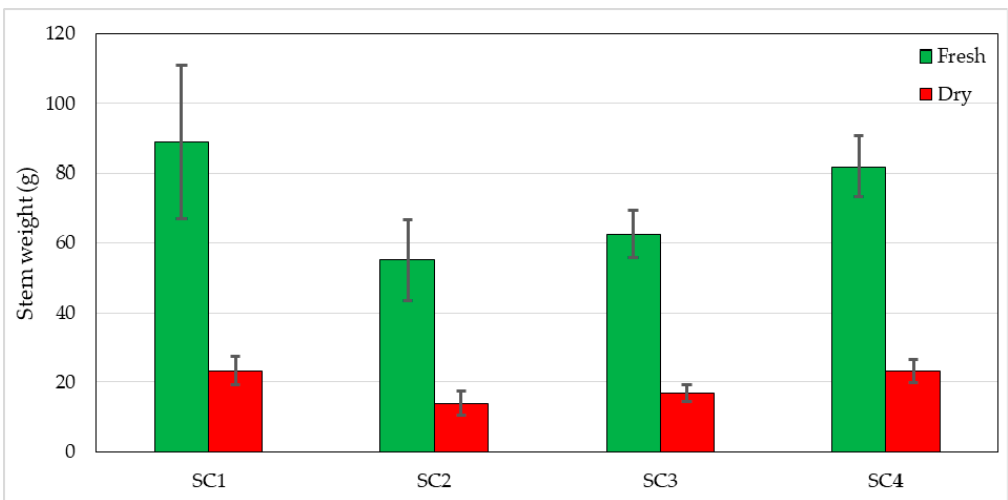
Figure 8. Mean values of fresh and dry stem weight (expressed as g/potted plant) related to the four Substrate Compositions (SC). The bars stand for standard deviation values ( n = 4).